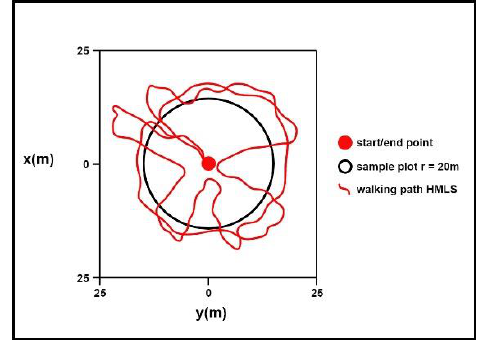
Figure 2.a GEOSLAM ZEB HORIZON ™ laser scanner.